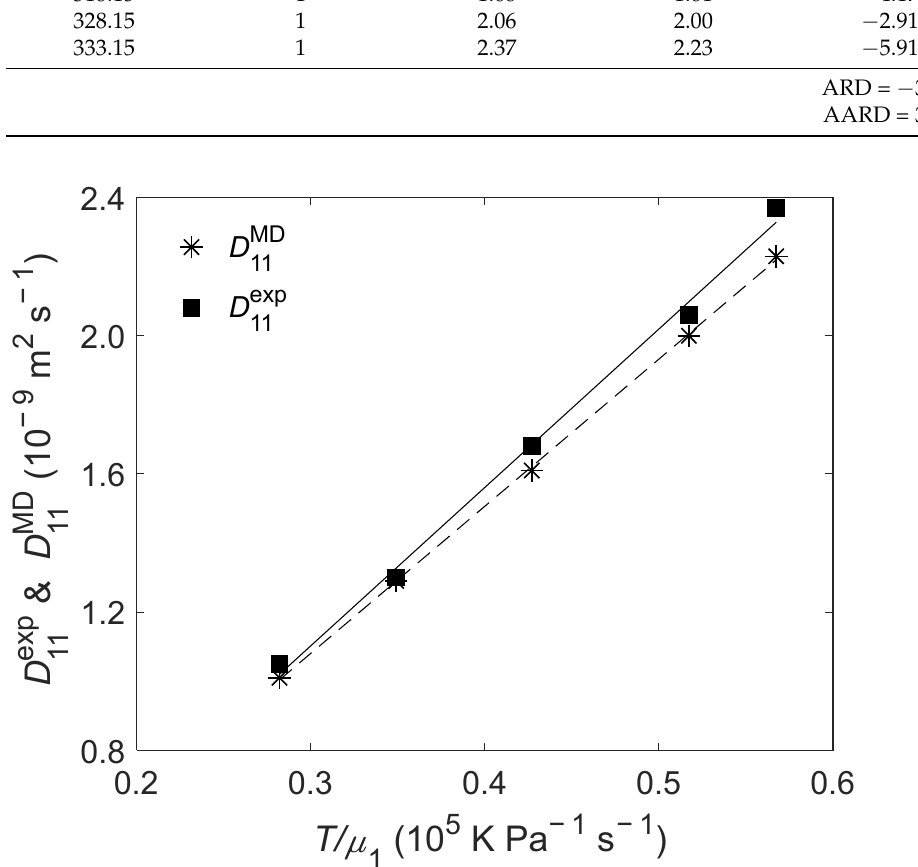
Figure 4. Experimental ( D exp , (cid:4) ) and computed ( D MD , *) self-diffusion coefficients of ethanol versus Stokes–Einstein abscissae. The viscosity values were estimated by the Mamedov equation, as proposed by Cano-Gómez et al. [44] .